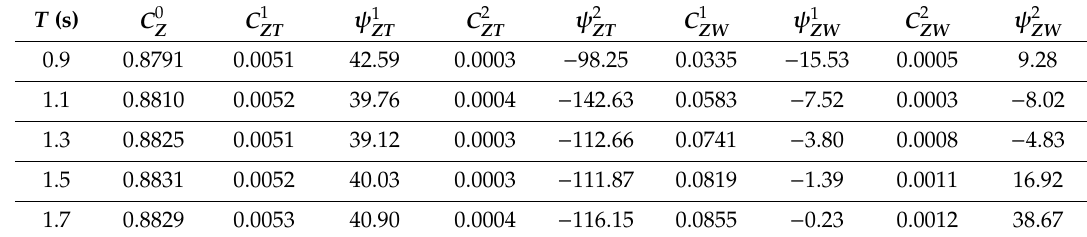
Table 4. Expansion coe ffi cient table of axial load coe ffi cient under the di ff erent wave periods.